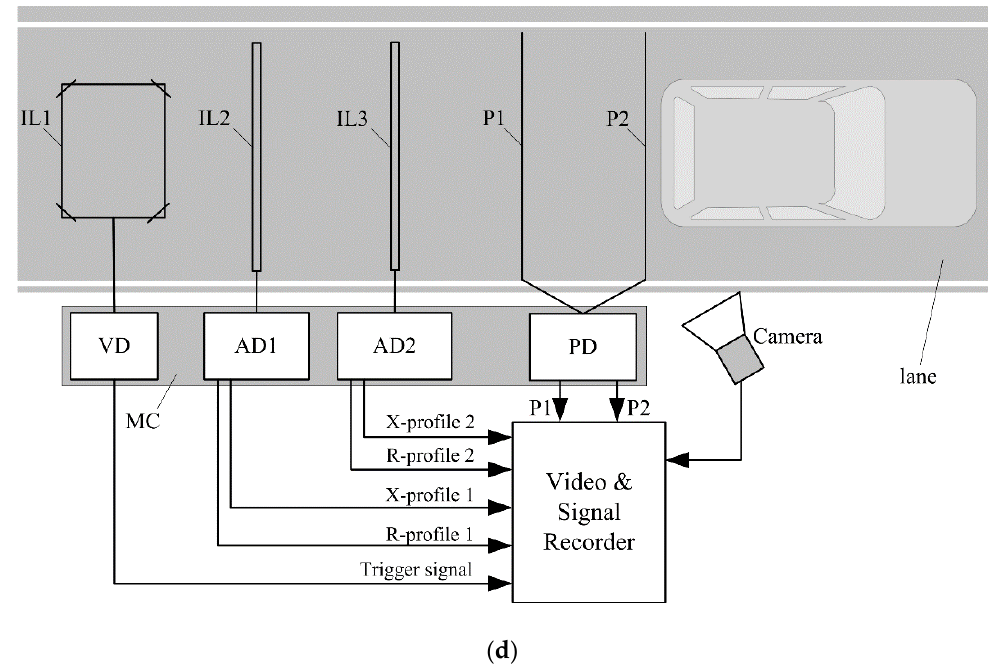
Figure 5. Multichannel measurement system: ( a ) multichannel conditioning system; ( b ) single card of the system; ( c ) graphical user interface of the system; ( d ) research stand diagram, where: IL1—sensor for vehicle detection; IL2 and IL3—narrow IL sensors for axle detection; P1 and P2—piezoelectric load sensors for axle detection; MC—multichannel conditioning system (shown in Figure 5a) equipped with dedicated cards for individual sensors (VD—vehicle detector card; AD1 and AD2—axle detection cards, PD—card for piezoelectric sensors). Table 1. Vehicle groups in the test base, where N —number of vehicles in the group. No. Vehicle Description in Group N 2-axle passenger vehicle with aluminum rims